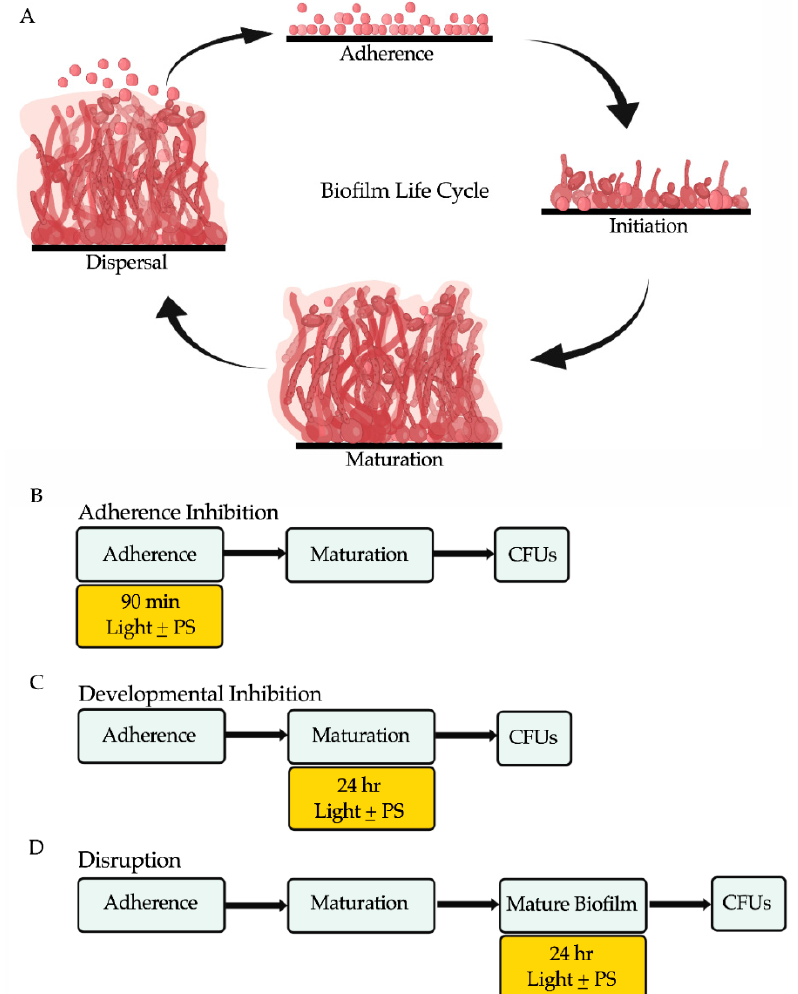
Figure 1. The C. albicans biofilm life cycle and the biofilm assays used in this study to assess the antibiofilm properties of visible lights and photosensitizing compounds. ( A ) The C. albicans biofilm life cycle occurs in four sequential stages: adherence, initiation, maturation, and dispersal. In the adherence stage, planktonic yeast-form cells adhere to a surface. In the initiation stage, the yeast-form cells proliferate forming an anchoring basal cell layer and begin to differentiate into hyphal and pseudohyphal cells. In the maturation stage, the hyphal cells elongate, and a protective extracellular matrix surrounds the cells. In the dispersal stage, yeast-form cells are released from the biofilm and the life cycle repeats. ( B ) Overview of the adherence inhibition biofilm assay, where the visible light of interest with (+) or without (-) the photosensitizing compound (PS) of interest were present during the 90-min adherence stage of biofilm formation. ( C ) Overview of the developmental inhibition biofilm assay, where the visible light of interest with (+) or without ( − ) the PS of interest were present during the 24 h maturation stage of biofilm formation. ( D ) Overview of the disruption biofilm assay, where the visible light of interest with (+) or without ( − ) the PS of interest were present for an additional 24 h on a mature (24-h) biofilm. Colony forming units (CFUs) were measured to determine viable cell counts at the end of each biofilm assay. This figure was creating using BioRender.com.